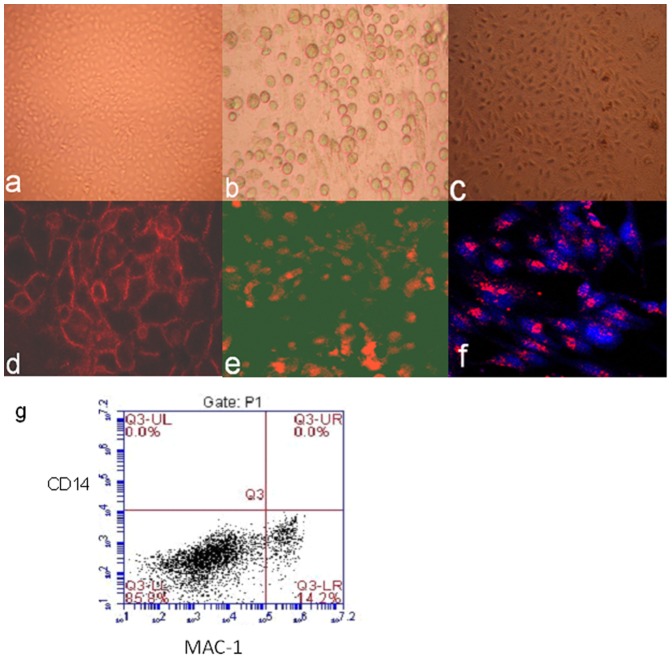
Cell culture and identification.Porcine aortic endothelial cells (a), hepatocytes (b), and liver sinusoidal endothelial cells (c) were in culture. The primary cells where then tested by anti- CD31 antibody(d), anti-hepatocyte specific antigen antibody (OCH1E5) (e), and Dil-Ac-LDL up-take(f) and examined under fluorescence microscope.To understand MAC-1 receptor expressed in liver sinusoidal endothelial cells,flow cytometry test for MAC-1 and CD14 in cells was done(g). The expression rate of Mac-1 in cells was 14.2%. In another hand, CD14 expression in cells was negative. It meaned that all the cells were not Kupffer cells.